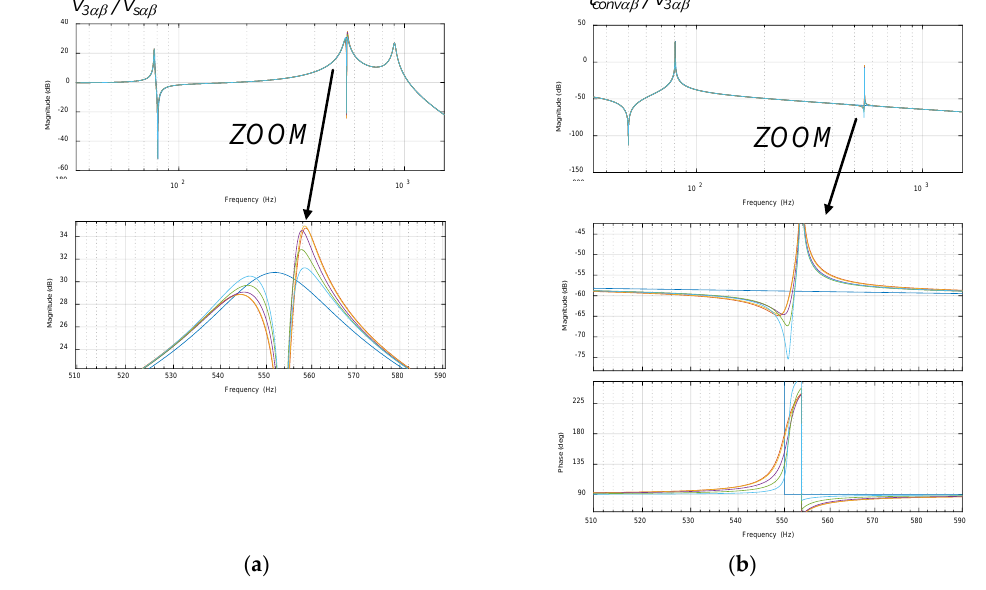
Figure 15. Bode plots of the voltage at the Pcc and the admittance of the ACISEF with different active R v 1 - L v 1 values programmed at 550 Hz ( R v 1 = 0.75 k Ω is kept constant and L v 1 = 218.8 mH is multiplied by factors (0 0.1 0.5 1 2)). ( a ) Bode plot of v 3 αβ ( s )/ v sαβ ( s ), ( b ) Bode plot of i convαβ ( s )/ v 3 αβ ( s ). However, when a variation at the AC impedance occurs, for instance 1.3· C 1 , as in one of the examples from the previous sections, it was found that using a pure active negative inductance rather